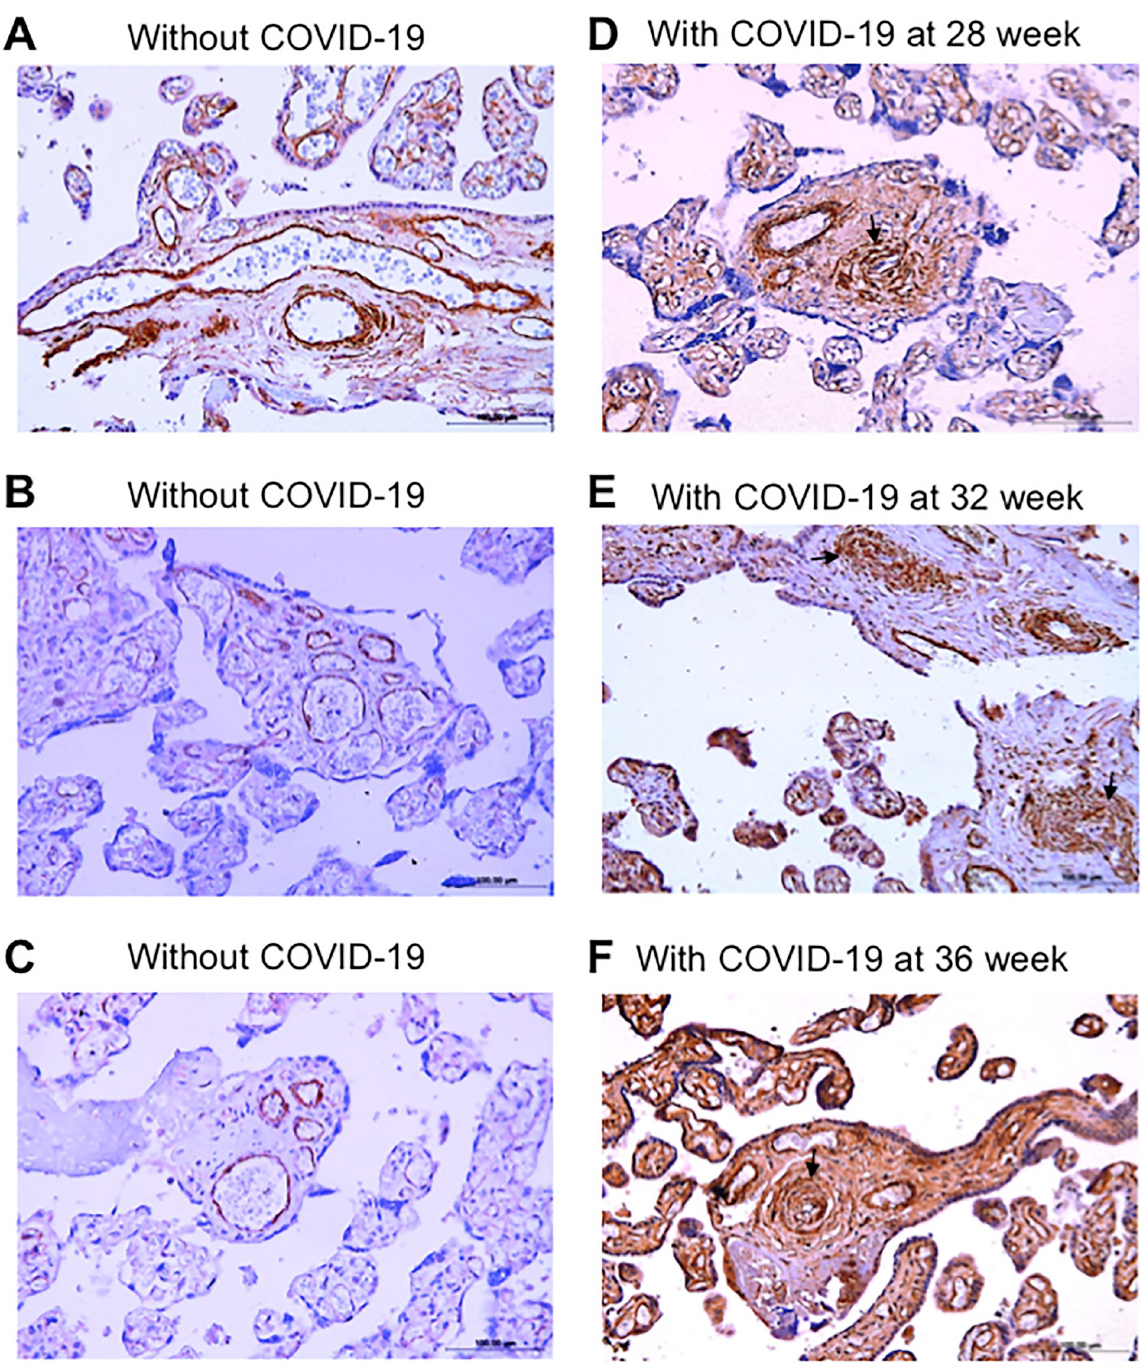
Fig 5. Immunohistochemistry of the Kv11.1 channels in the placental arteries of women who gave birth without or with COVID-19 during pregnancy. (A-C) Immunohistochemistry images of three women who gave birth without contracting COVID-19 (40 weeks of gestation). (D-F) Immunohistochemistry images of three women who gave birth (40 weeks of gestation), but contracted COVID-19 at 28, 32, or 36 weeks of gestation. Magnification x200. Arrows indicate remodeled vessels.